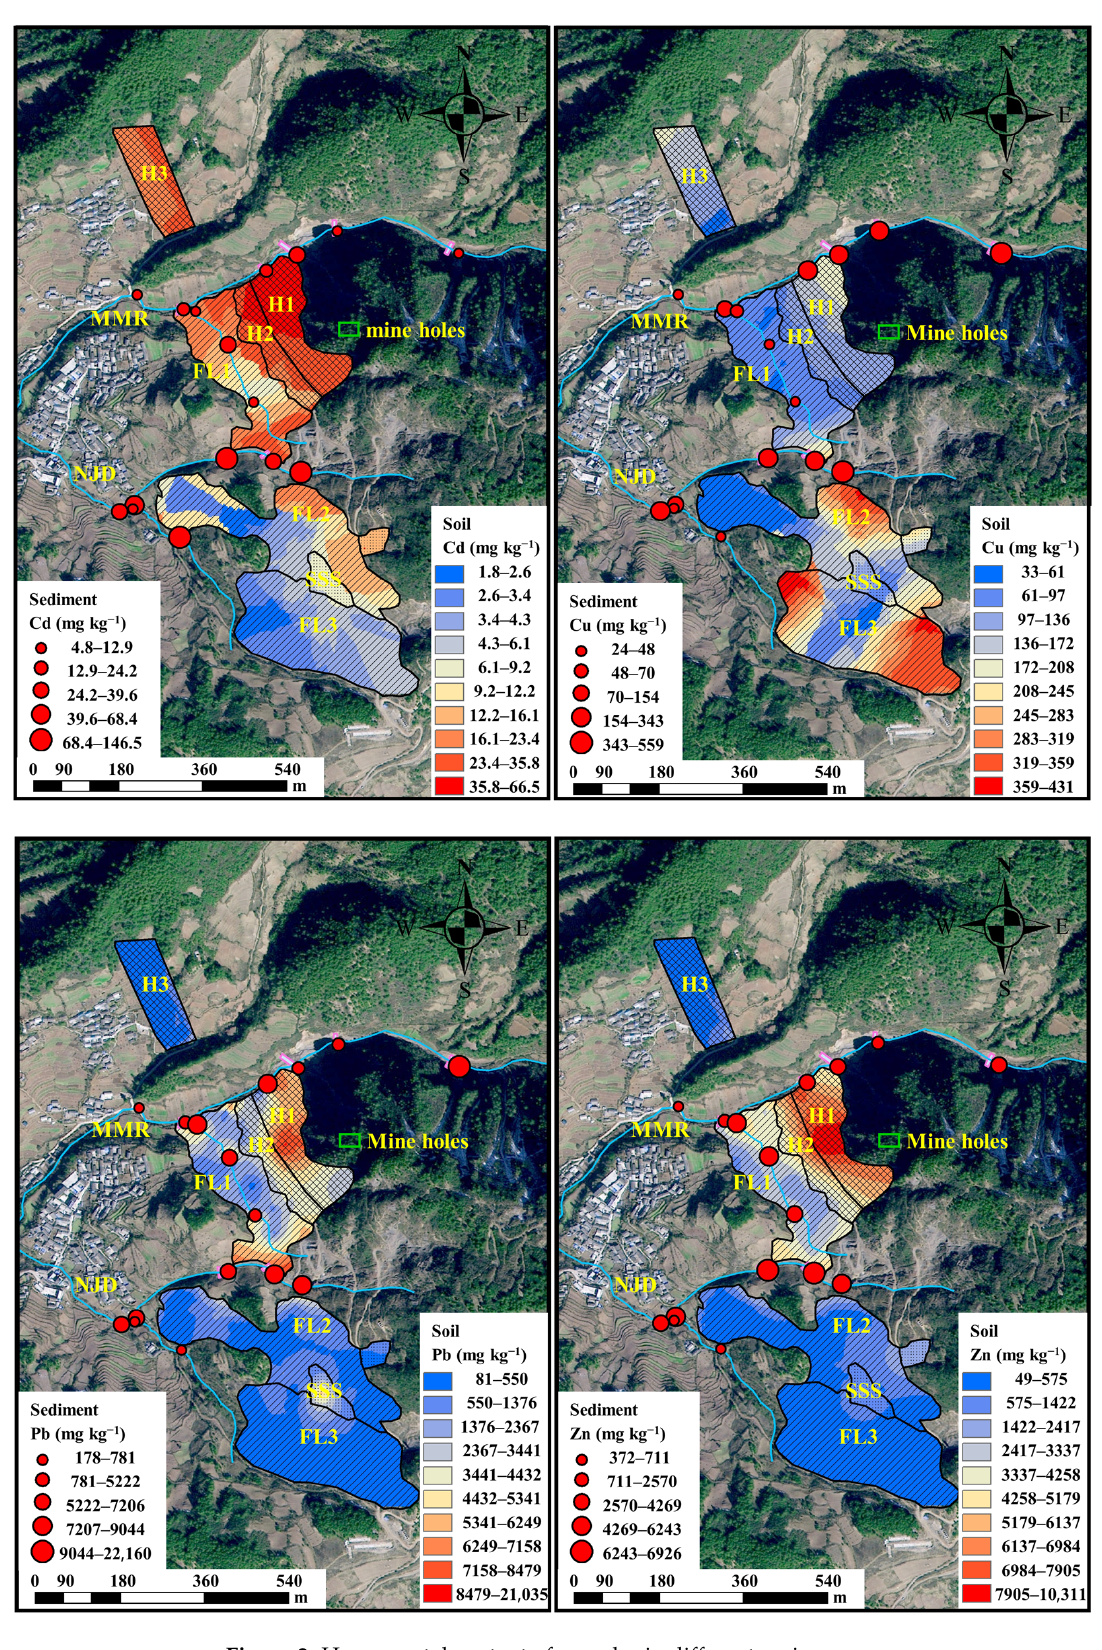
Figure 2. Heavy metal content of samples in different regions.